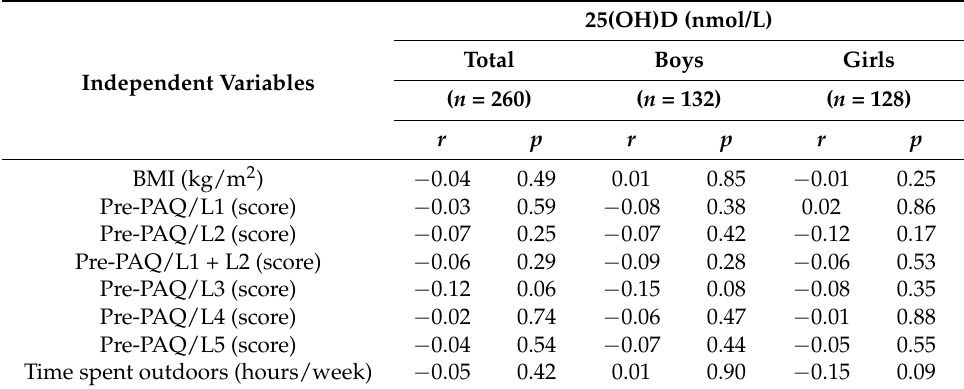
Table 2. Univariate associations between independent variables and 25(OH)D level.